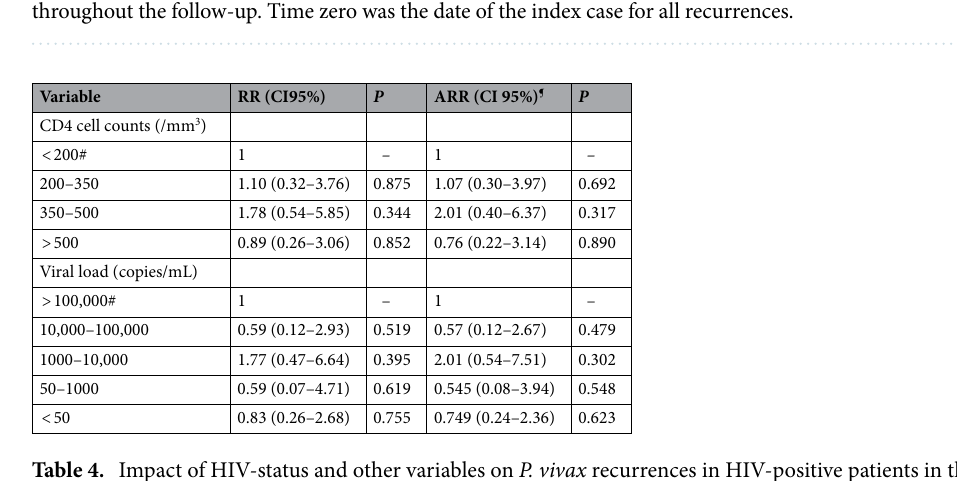
Figure 2. ( A ) Kaplan–Meier survival estimates comparing the time to first Plasmodium vivax malaria recurrence (in days). ( B ) Median of the number of Plasmodium vivax malaria recurrences by HIV status groups throughout the follow-up. ( C ) Graphical representation of Plasmodium vivax malaria recurrences densities throughout the follow-up. Time zero was the date of the index case for all recurrences.